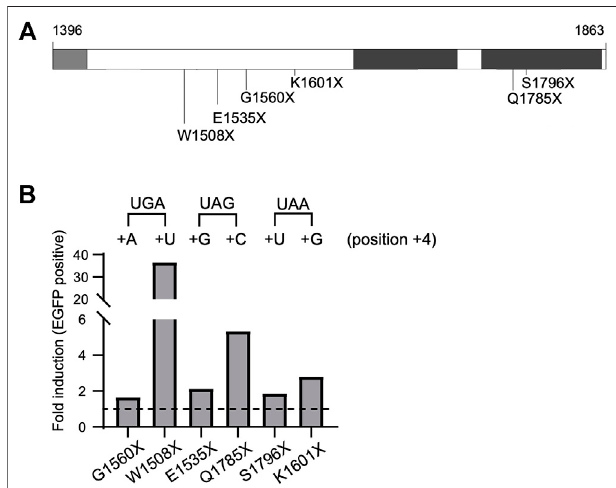
FIGURE3| BRCA1PTCreadthroughinductiondependsonstopcodon context. (A) Schematic representation of BRCA1-EGFP protein (amino acid residues 1,396 – 1,863), enclosing part of the coiled-coil (light grey) and the tBRCT (dark grey) domains, naturally occurring PTC variants analyzed are indicated. (B) FACS analysis of HeLa BRCA1-EGFP cells encoding differentPTC variants. Cells wereeither non-treated (NT) or treated with G418 (300 μ g/ml) for 48 h and EGFP fl uorescence was evaluated. Graphical representation of EGFP fold induction in treated cells (relative to untreated cells). Termination sequences are indicated on top, nucleotides at position +4 are depicted. Representative data from 3 independent